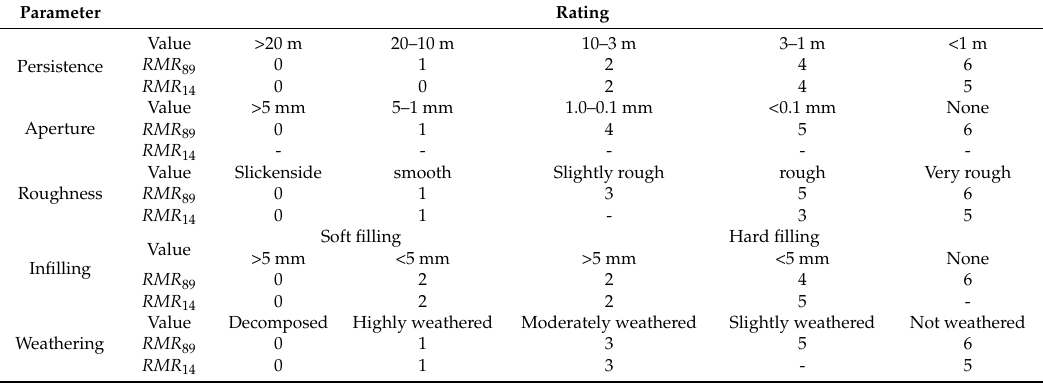
Table 3. Rating comparison for joint condition in two different versions of RMR : RMR 89 and RMR 14 .